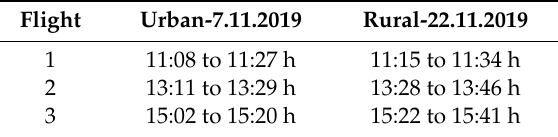
Figure 2. Rural area: orthophoto and DEM. Table 1. Dates and times of the image acquisition flights.